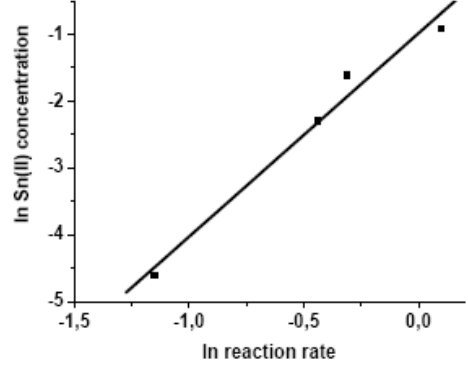
Figure 5. Plot linear of ln [SnCl the ethanolysis of oleic acid).